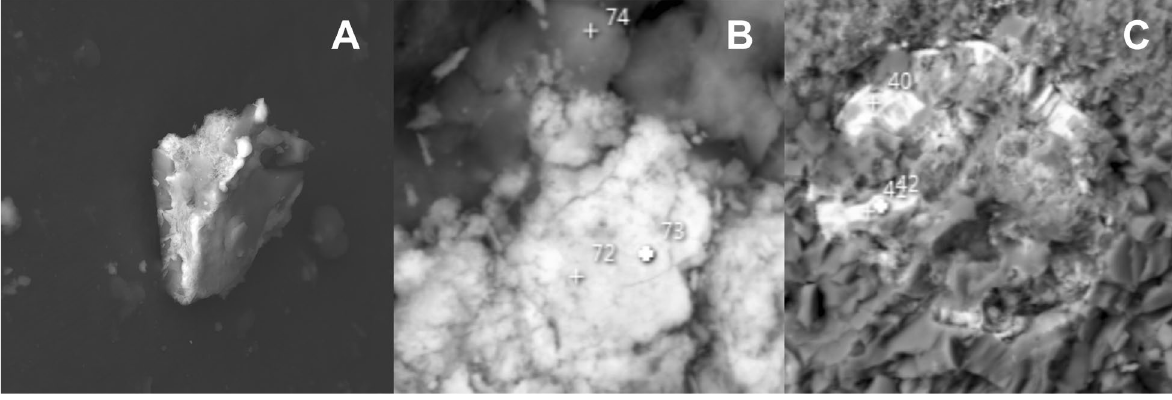
Fig. 7 Rare-metal phases from granites of the Rakovka massif: a Cerium silicate (cerite); b Manganese crusts with cerium; c REE fluorocarbon- ate